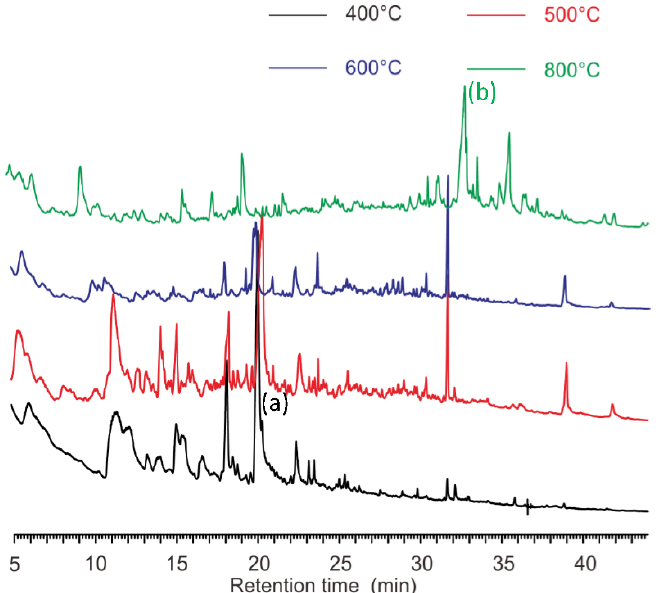
Figure 6. Pyrograms of M. harundinacea at four different temperatures. ( Peak a ): characteristic peak (retention time of 20.25 min) at 400 °C (black line); ( Peak b ): characteristic peak (retention time of 32.71 min) at 800 °C (green line).